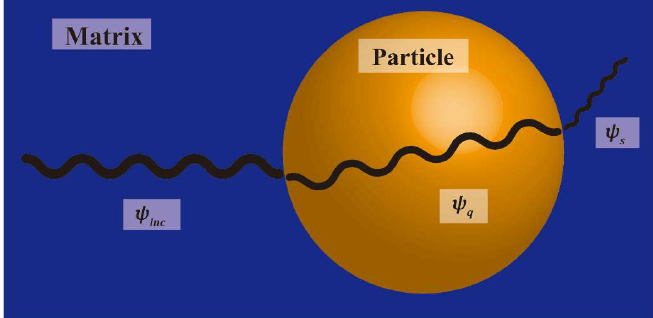
Figure 6. Schematic of elastic waves propagated by a single particle in PPC.